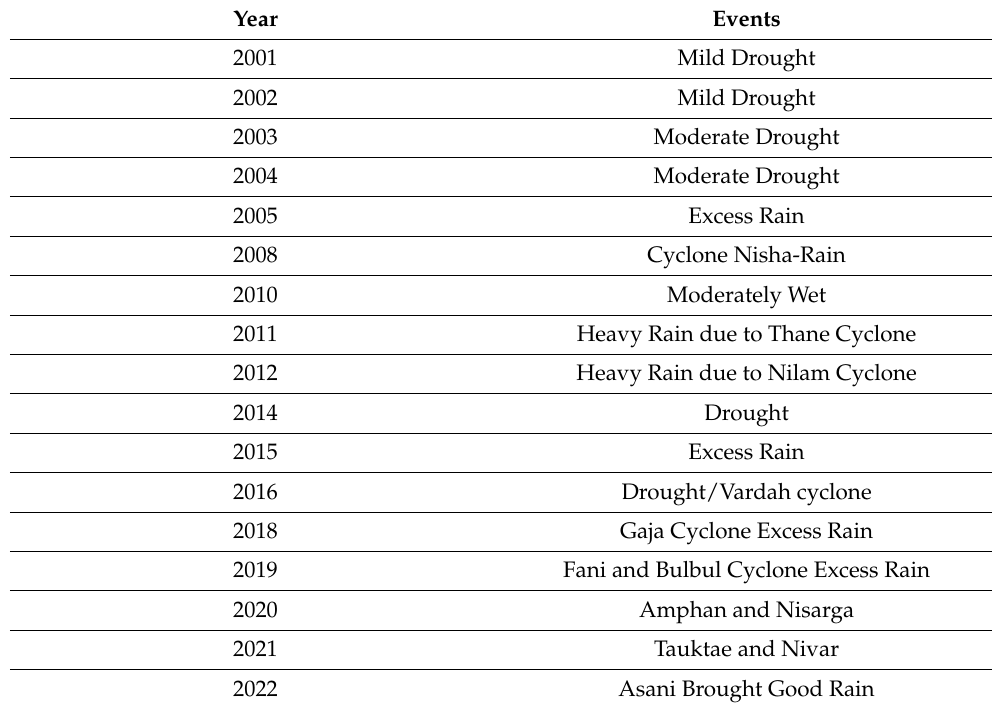
Table 1. Disaster profile of the state that impacted agriculture for the past 20